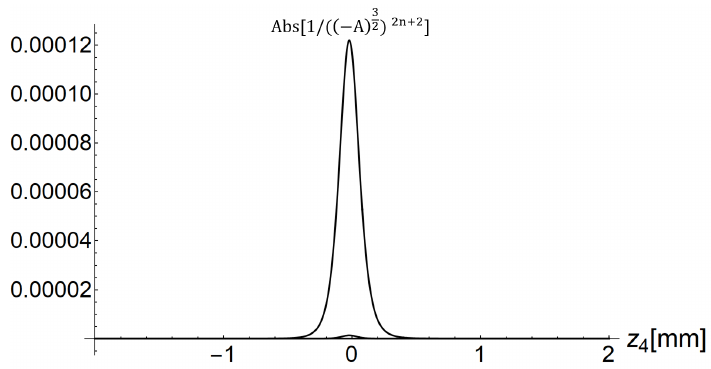
Figure 8. The absolute value of the Equation (21b) containing A ( 4 ) coefficient for two values of n = 0 and n = 1, in case of even topological charge. For growing n the absolute value drops rapidly. So for n = 1 the maximum value is 1.2 × 10 − 4 and the plot is hardly visible in this figure. As a result, the n = 0 coefficient play a major role in the Kappa function. For n = 2 the maximum value is 1.3 × 10 − 6 . For any next n the maximum value decreases by two orders.